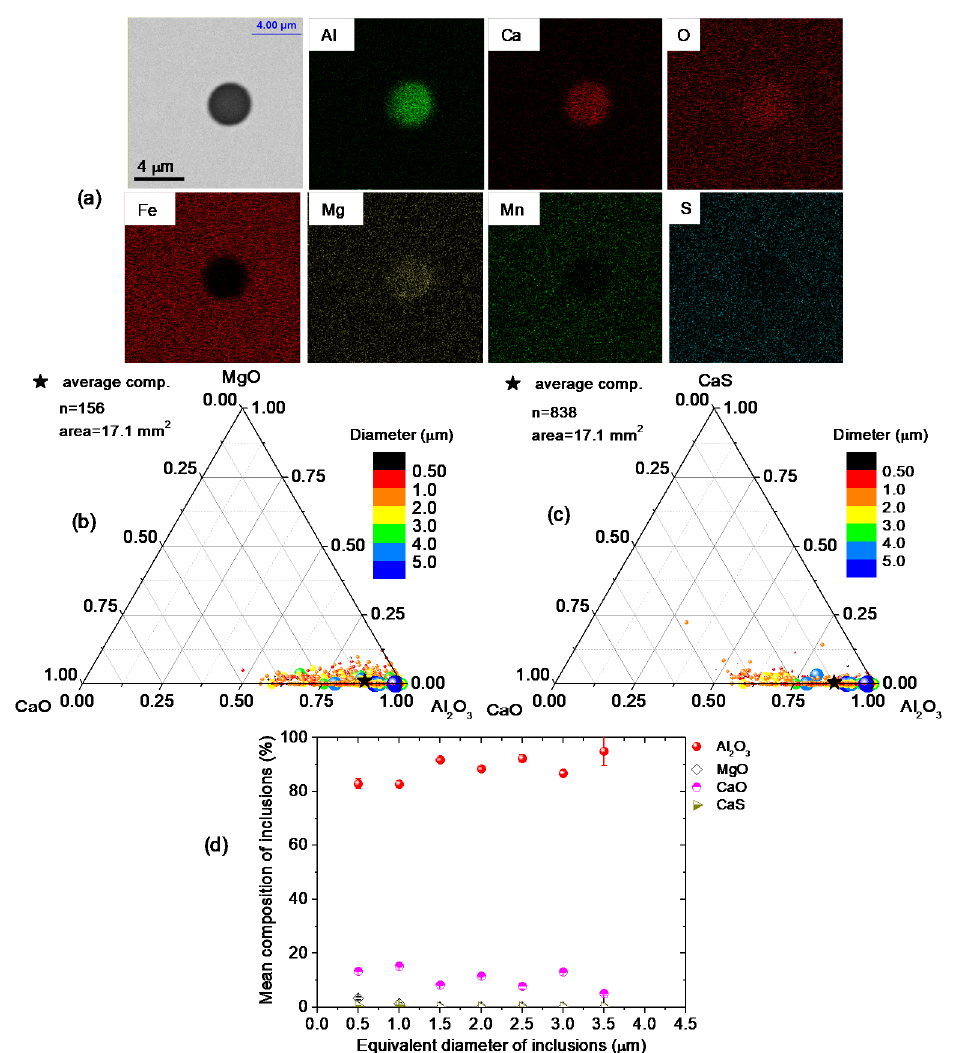
Figure 2. ( a ) Element mapping of a typical inclusions formed at the cooling rate of 10 K/s. Summary of the ( b – c ) composition and size distributions of inclusions and ( d ) variations in composition of inclusions against its diameter formed at the cooling rate of 10 K/s.